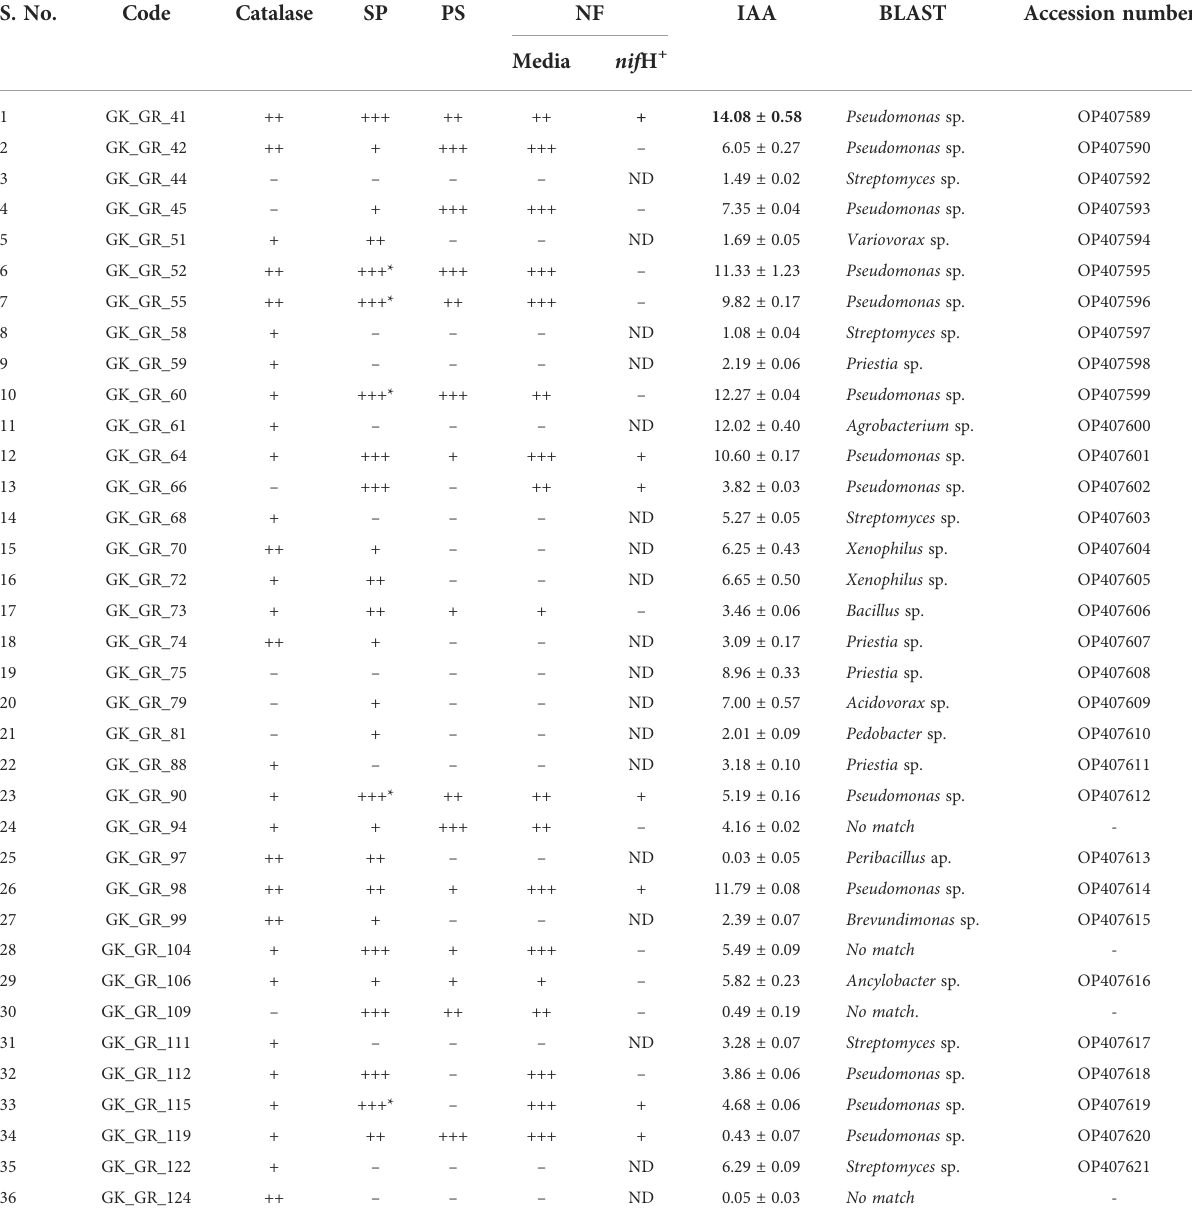
TABLE 2 Bacterial characterization of the isolates from the rhizosphere of snowbrush ceanothus from the greenhouse conditions based on catalase production, siderophore, phosphate solubilization, nitrogen fi xation, and IAA production. S.